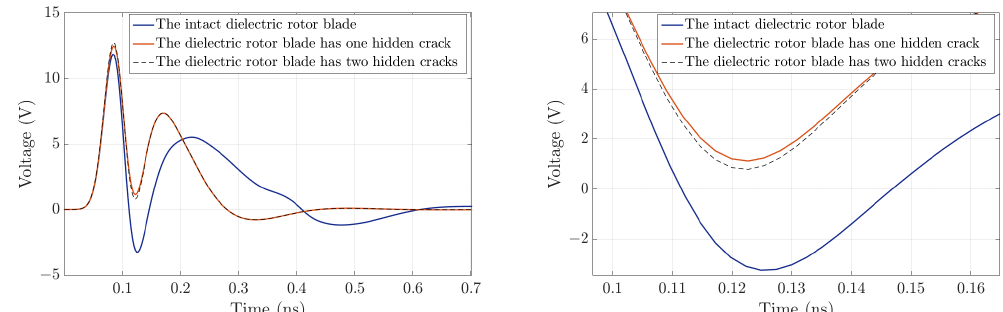
Figure 33. Comparison between the reflected voltage in the undamaged dielectric rotor blade and the cracked dielectric rotor